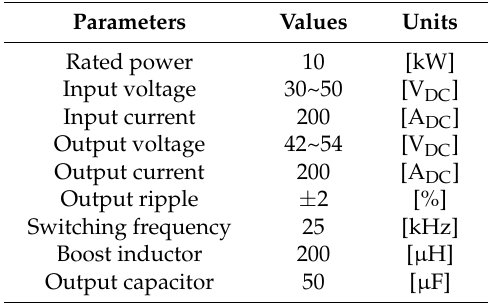
Figure 10. Busk-boost converter hardware configuration. Table 1. The electrical specification of the buck-boost converter.